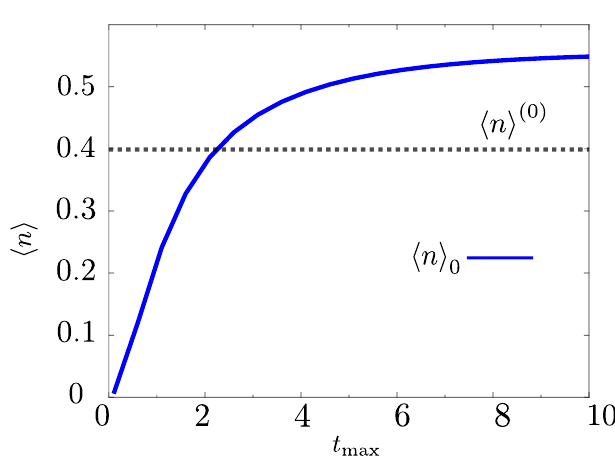
〉 = | 0 〉 . as a function of t for the reset state | ψ Figure 6: Mean activity 〈 n 〉 r 0 max The maximum reset time t is measured in units of ω − 1 . The dashed horizontal max 1 ( 0 ) line 〈 n 〉 is the mean activity associated with the reset-free SCGF θ ( 0 ) ( k ) . For suf- ficiently large values of t the system becomes more active than in the reset-free max because resetting hinders the shelving into the state | 2 〉 . In the limit of extremely → 0, the system is continuously projected small maximum reset time, instead, t max = 4, to the inactive state | 0 〉 and the activity is zero. In the Figure we set γ = 0.2, K 1 ω = 1 / 10 in units of ω . 2 1